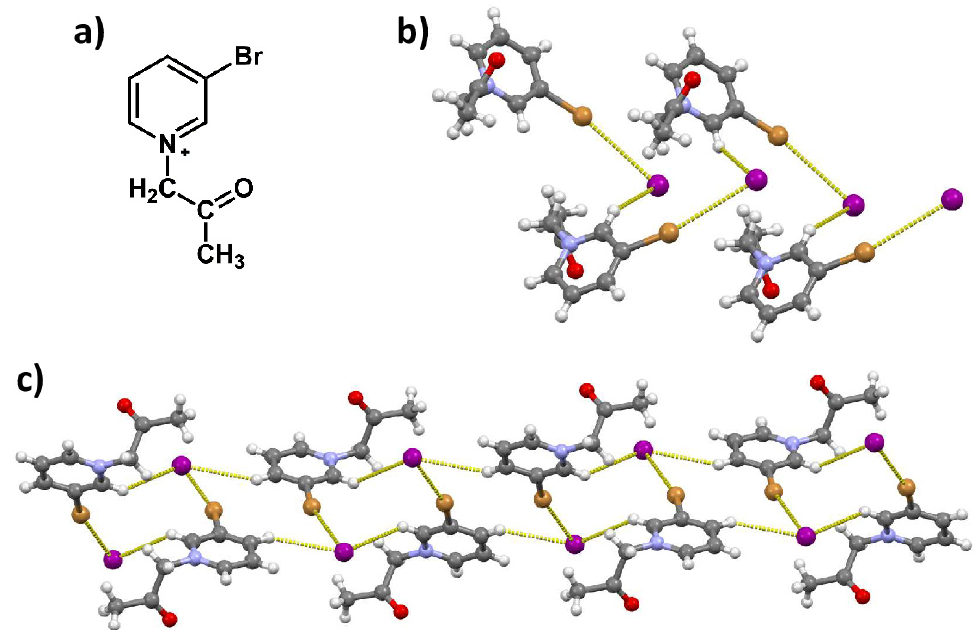
Figure 4. ( a ) [ N - Ace - 3-BrPy ] + cation; ( b ) [ N - Ace - 3-BrPy ] + cations and iodide anions connected through C − Br ⋯ I − halogen bonds and C − H ⋯ I − hydrogen bonds into chains in the structure of [ N - Ace - 3-BrPy ]I; ( c ) View along crystallographic b axis—chains connected into layer through C − H ⋯ I − hydrogen bonds.